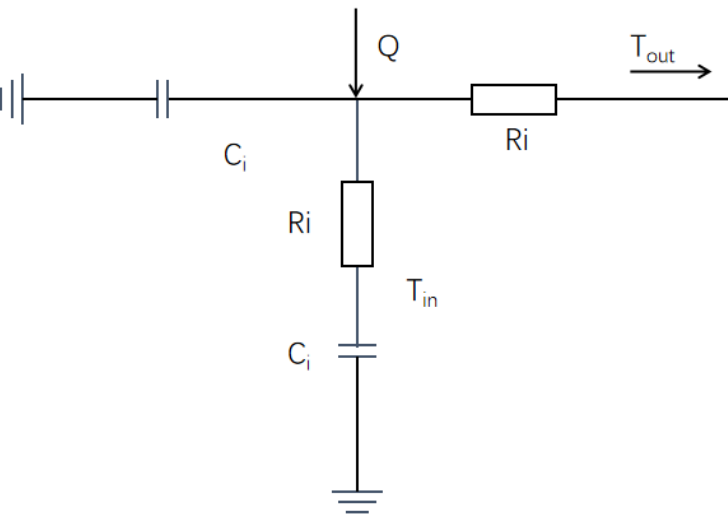
Figure 2. Equivalent thermal parameter model of a single air conditioning unit.